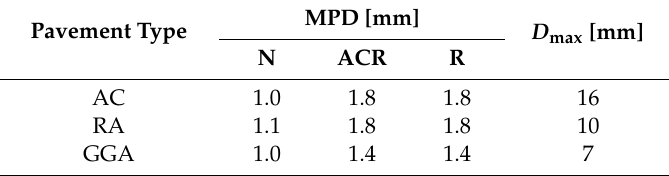
Table 1. Mean profile depth (MPD) and maximum aggregate size for each pavement condition.